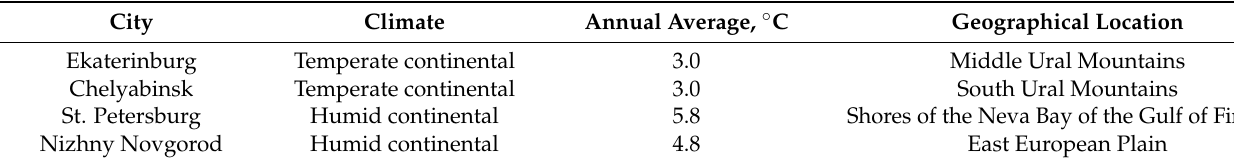
Table 5. Main climatic characteristics of studied cities.